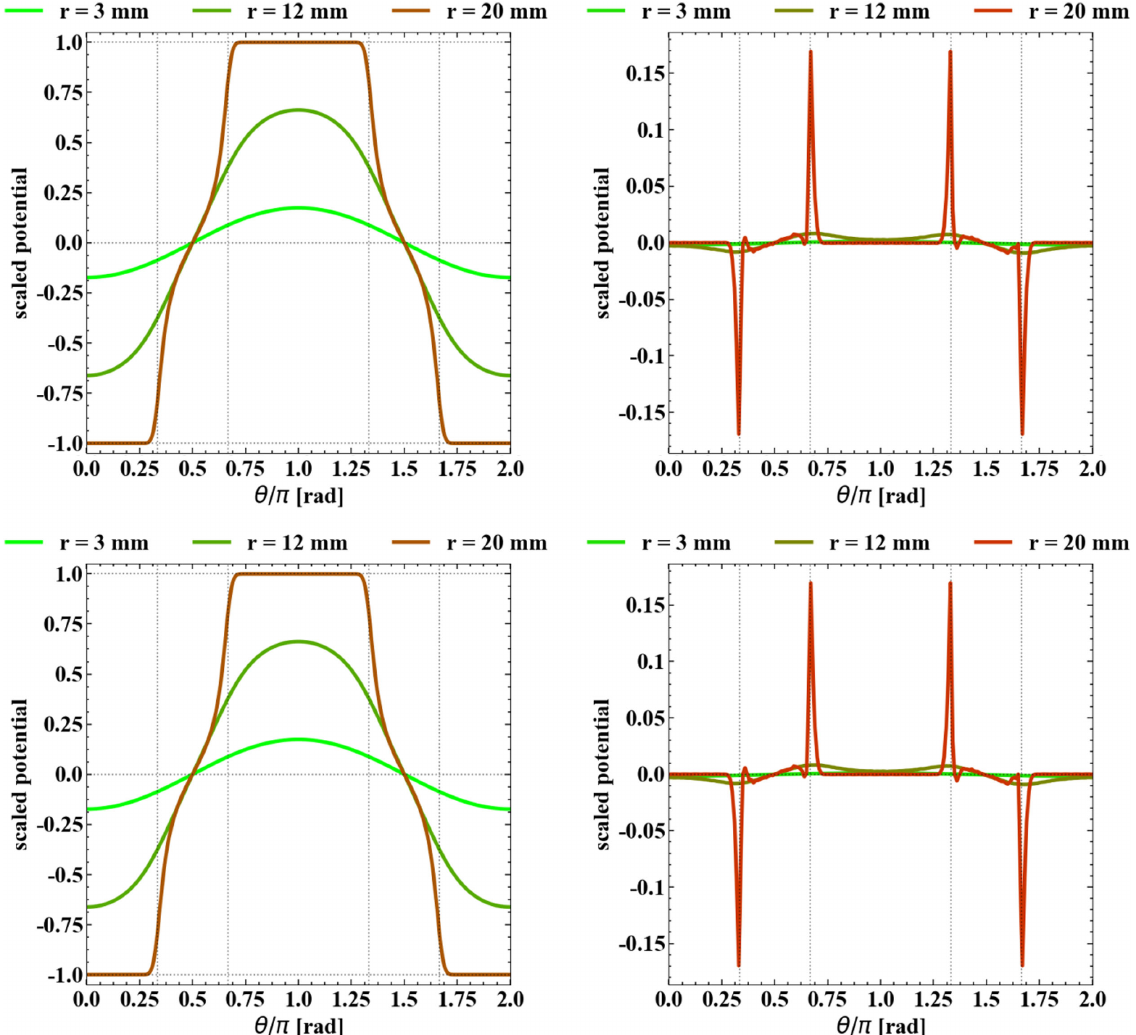
FIG. 3. Top left: The scaled potential Φ =V using the least square method as a function of the angle θ for different values of the radial p distance r for plates with b ¼ 20 mm, a ¼ 25 mm, θ 0 ¼ π = 3 . Top right: The absolute relative difference between the solutions found using the least squares method and the program FEMM. The difference is well below 5% everywhere except at the tips of the plates. Bottom left and right: Same as in the top row, except that the projection method is used. The two series expansions give nearly the same